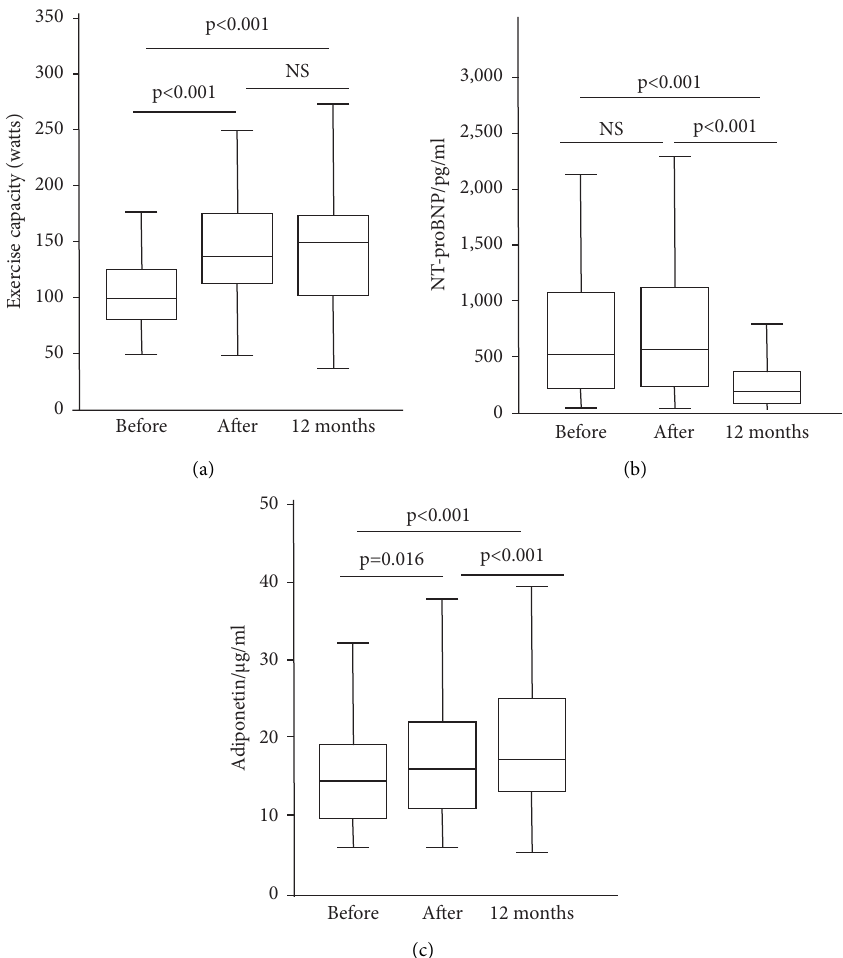
Figure 2: Serial changes in exercise capacity (a), blood level of N-terminal part of the pro-brain natriuretic peptide (NT-proBNP) (b), and adiponectin (c) before and after cardiac rehabilitation and at 12-month follow-up. The data are expressed in median with quartiles and the minimal and